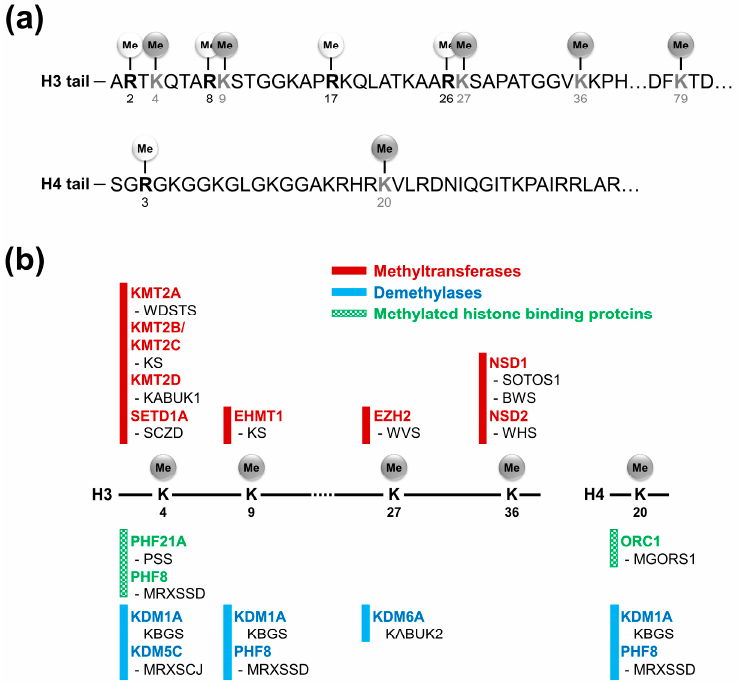
Figure 1. Histone methylation and neurodevelopmental disorders: ( a ) histone methylation sites in the tails of histone H3 and H4; and ( b ) histone methyltransferases, demethylases, and methylated histone binding proteins linked with neurodevelopmental disorders. Five methylation sites were associated with several neurodevelopmental disorders. BWS, Beckwith-Wiedemann syndrome; KABUK1/2, Kabuki syndrome 1/2; KBGS, KBG syndrome; KS, Kleefstra syndrome; MGORS1, Meier-Gorlin syndrome 1; MRXSCJ, Mental retardation, X-linked, syndromic, Claes-Jensen type; MRXSSD, Siderius X-linked mental retardation syndrome; PSS, Potocki-Shaffer syndrome; SCZD, Schizophrenia; SOTOS1, Sotos syndrome 1; WDSTS, Wiedemann-Steiner syndrome; WHS, Wolf-Hirshhorn syndrome; WVS, Weaver syndrome.